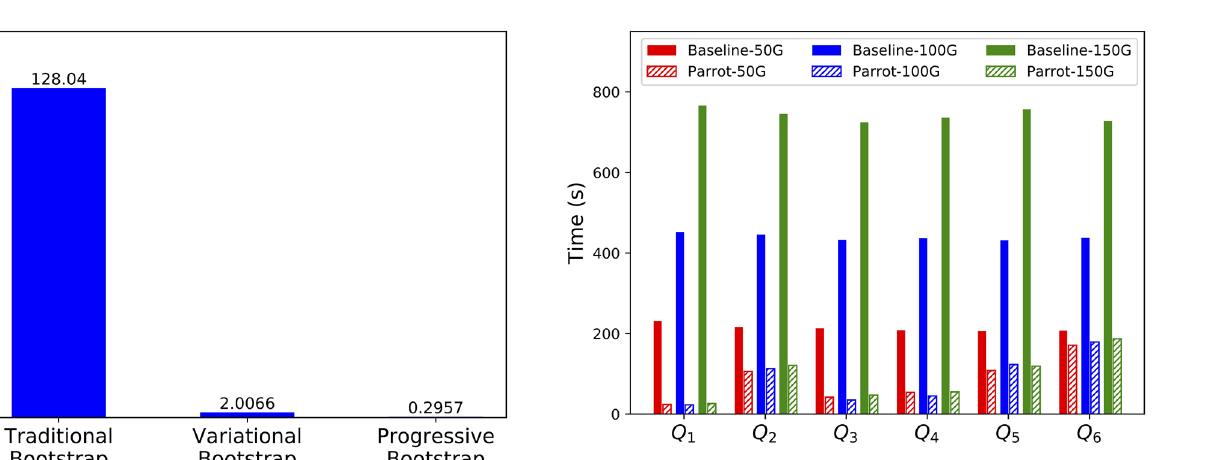
Fig. 5 Performance of bootstrap methods